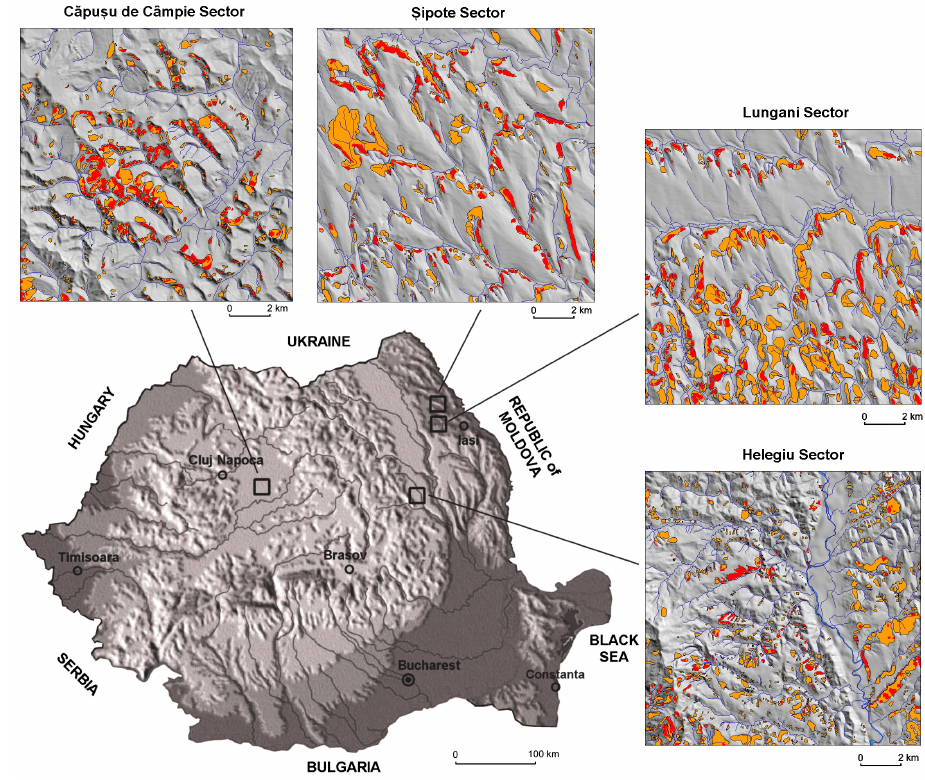
Fig. 1. Location of study areas, with landslide distribution (in orange), and active landslides (in red) overlaid on terrain hillshade.